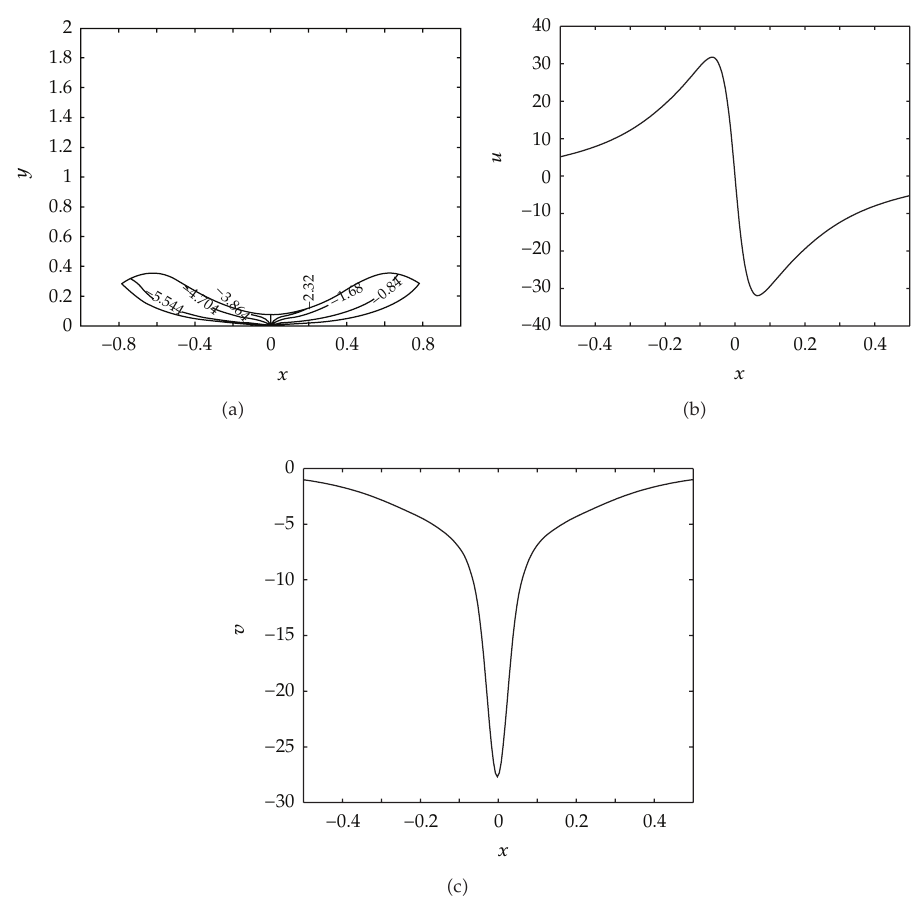
Figure 7: (cid:5) a (cid:6) Contour plot of the fluid motion within the modeled collapsing vessel (cid:5) of Figure 3 (cid:6) near the end of micturition. Also plotted are the (cid:5) b (cid:6) horizontal and (cid:5) c (cid:6) vertical velocities along the horizontal